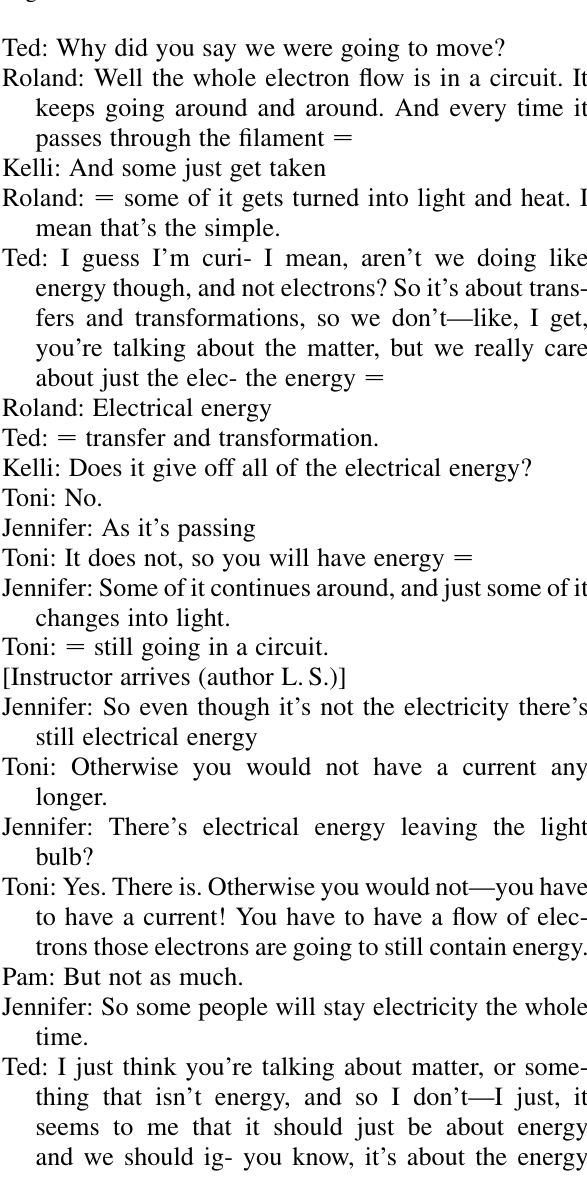
VIDEO 1. Participants prepare to enact Energy Theater for an incandescent bulb burning steadily. In this episode, participants attempt to account for the fact that the current is exactly the same before and after the filament, yet some energy leaves the circuit through the